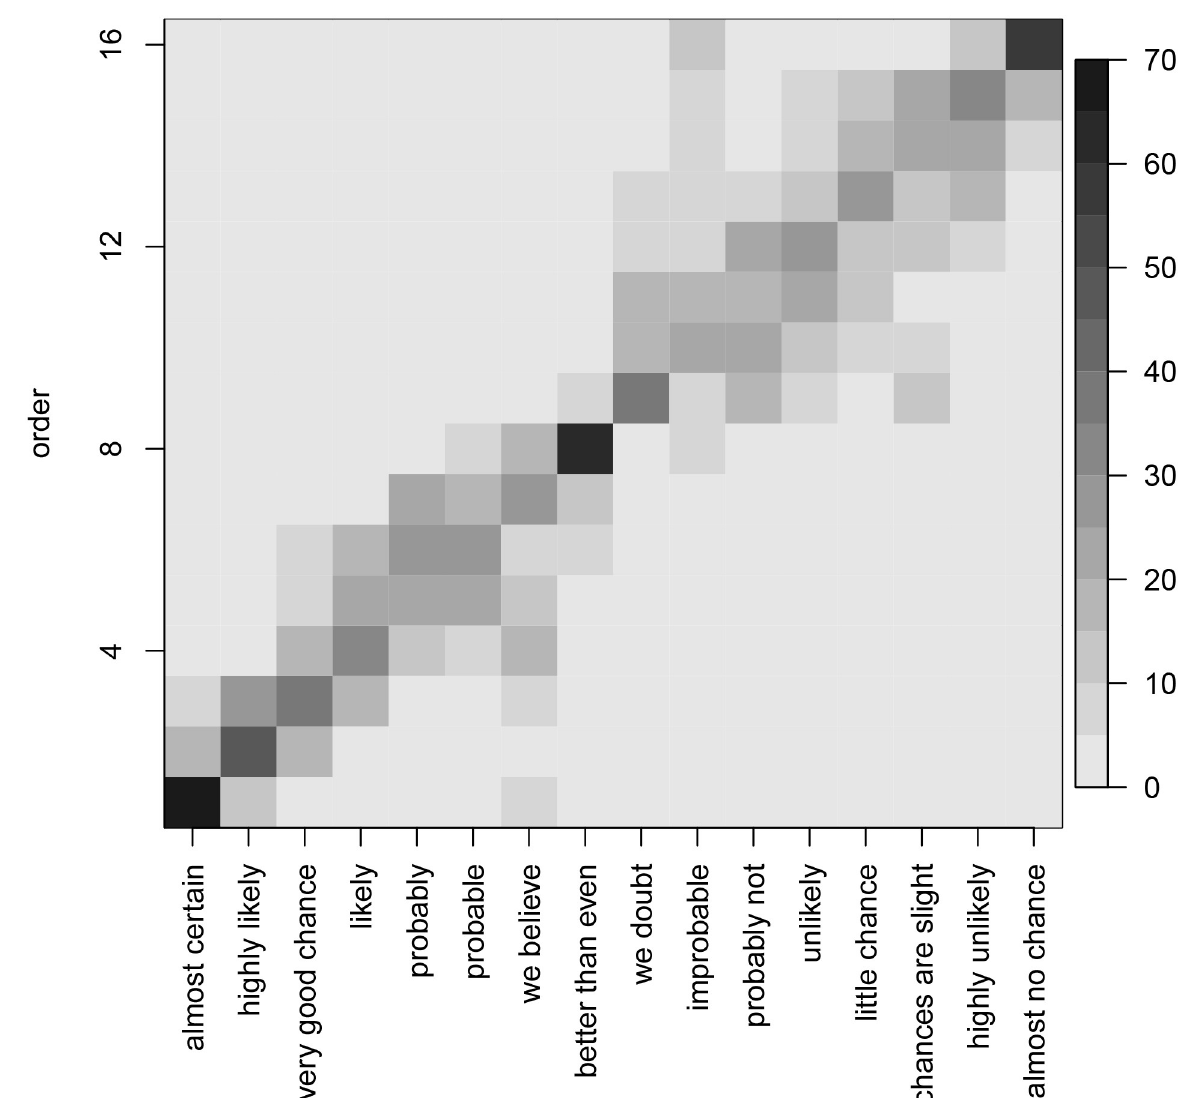
Fig 6. The average order of the probability-related context-free phrases as perceived by respondents with the “likelihood” prompt.